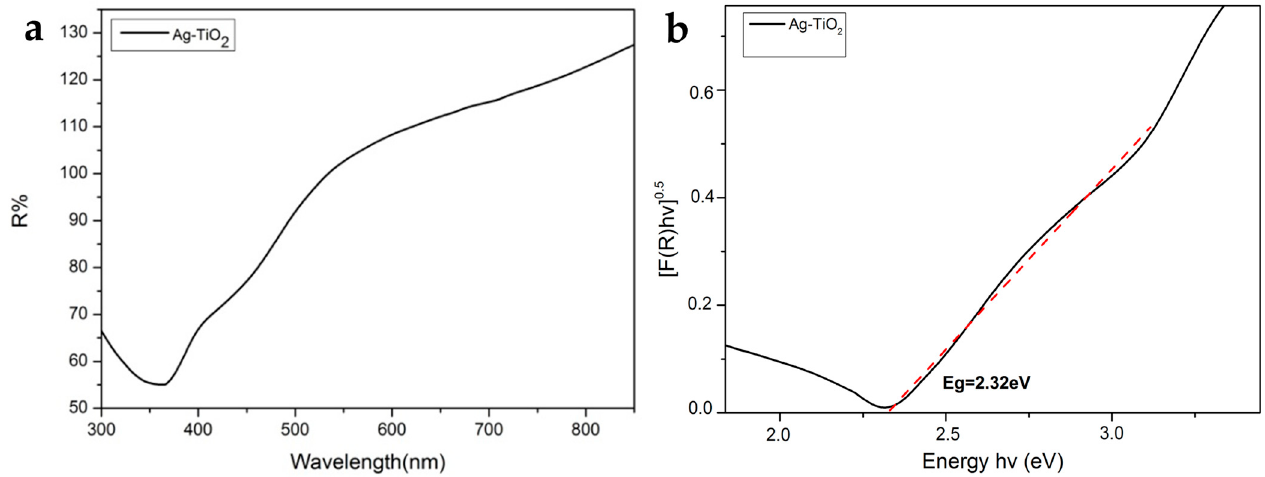
Figure 7. ( a ) F(R) reflectance as a function of wavelength for Ag-TiO 2 nanoparticles. ( b ) Optical energy band gap (E g ) of the Ag-TiO 2 nanoparticles.